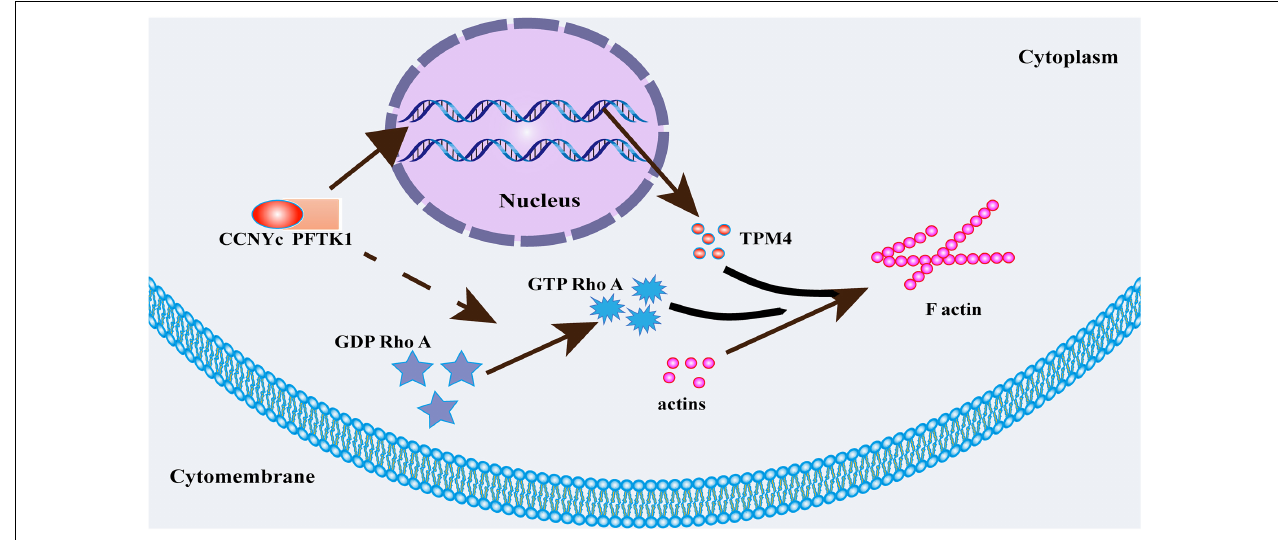
FIGURE 7 | Signal pathway of CCNYc promoting cell metastasis